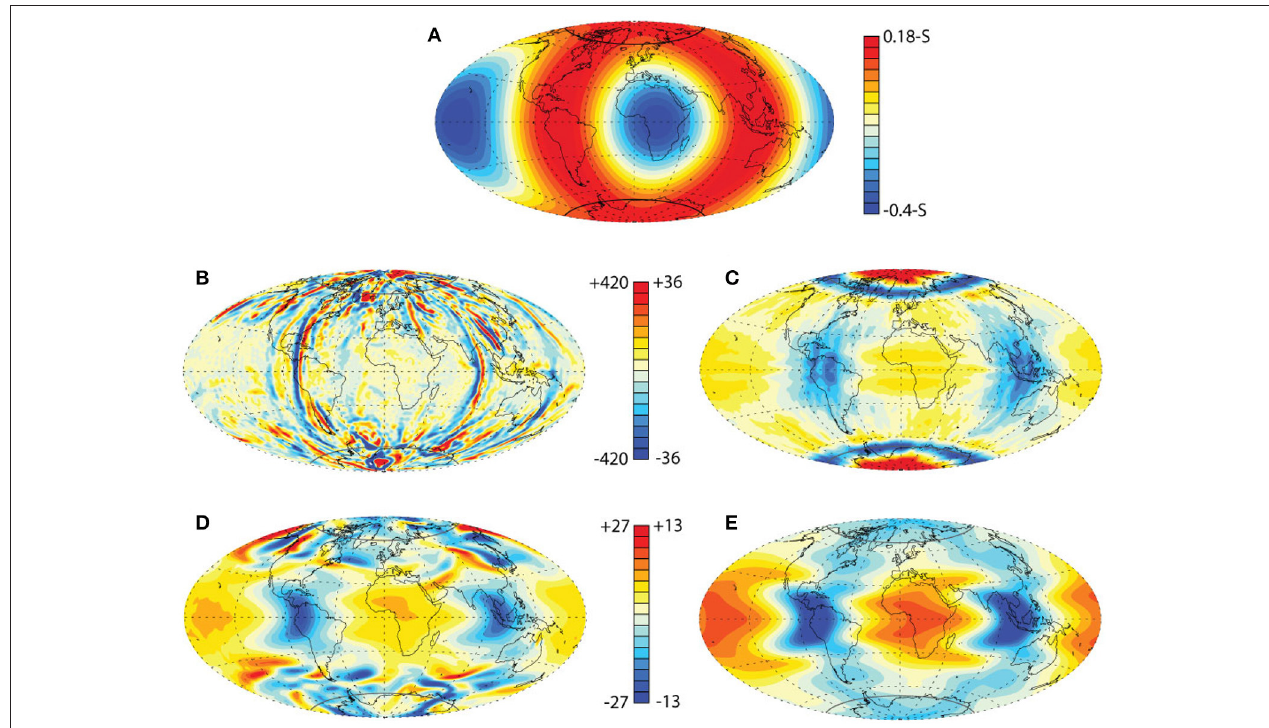
FIGURE 1 | Numerical dynamo heat flux and radial velocities near the outer boundary r o at Ra boundary; (B–E) are r 0.95 r o dimensionless radial velocity patterns. (B,C) are a snapshot and time average radial velocity for stratification parameter S = 0; (D,E) = are a snapshot and time average radial velocity for stratification parameter S = 0.3. Maximum and minimum dimensionless outer boundary heat fluxes are 0.18-S and –0.4- S , respectively. Velocity scales are in magnetic Reynolds number